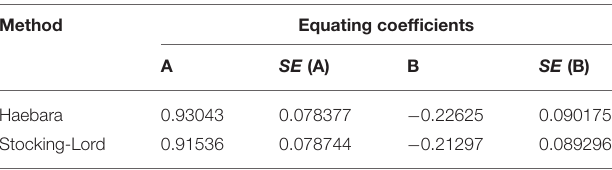
TABLE 4 | Linking coefficients obtained by different methods (Form A–R on Form B–R). Method